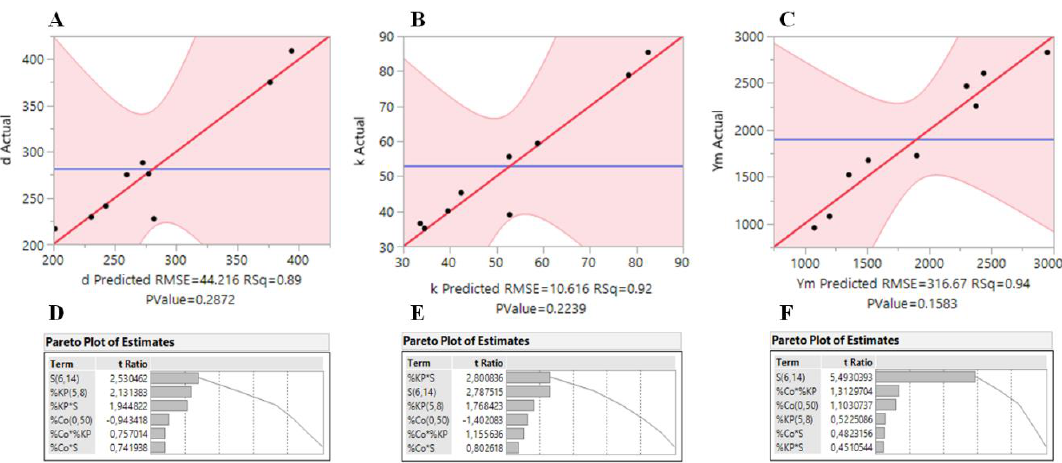
Figure 1. Actual vs. predicted responses ( A – C ) and Pareto plots ( D – F ) resulting from full factorial (2 3 ). Bulk density ( d ) in kg · m − 3 , thermal conductivity ( k ) in mW · m − 1 · K − 1 and Young’s modulus ( Y m) in kPa.